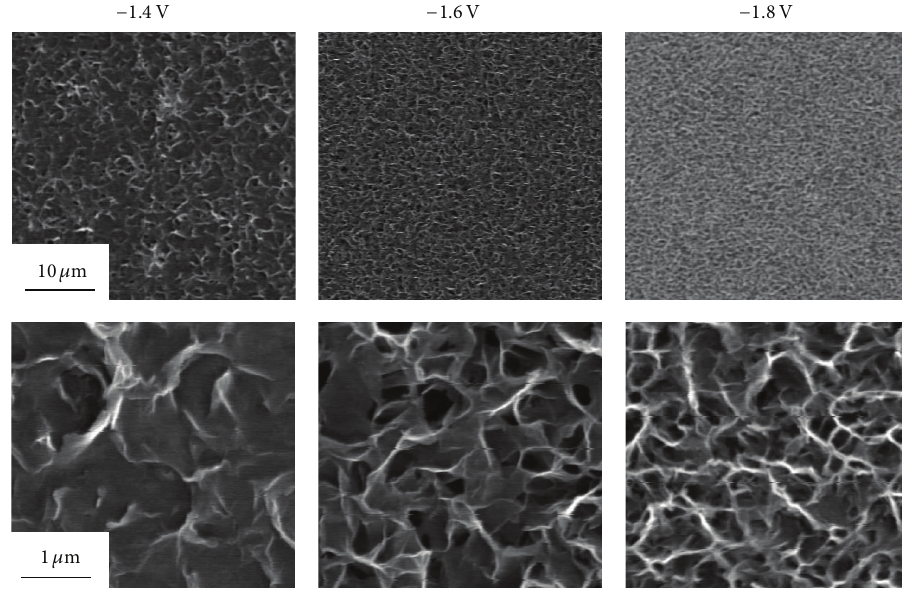
Figure 2: SEM images of coating films formed on AZ31 Mg alloy in 3mM Ca(H 2 PO 4 ) 2 , 7mM CaCl 2 for 30 min. at − 1.4V, − 1.6V, and − 1.8V.